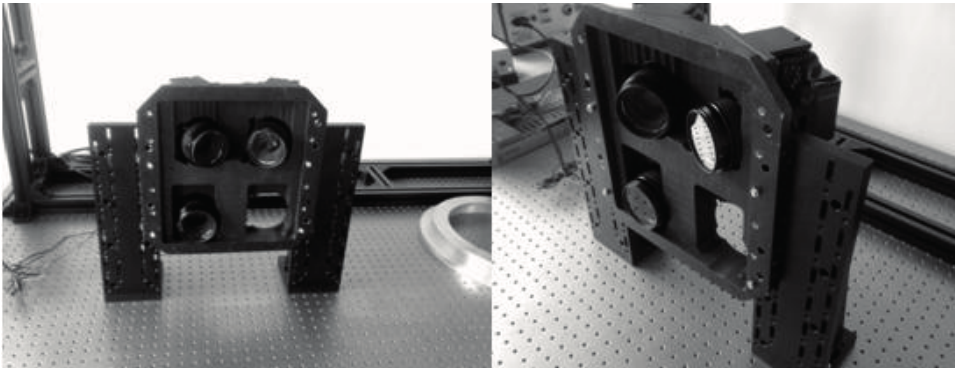
Figure 14. MADCII is set in the optical platform for the calibration of the IOEs and distortion of each camera.